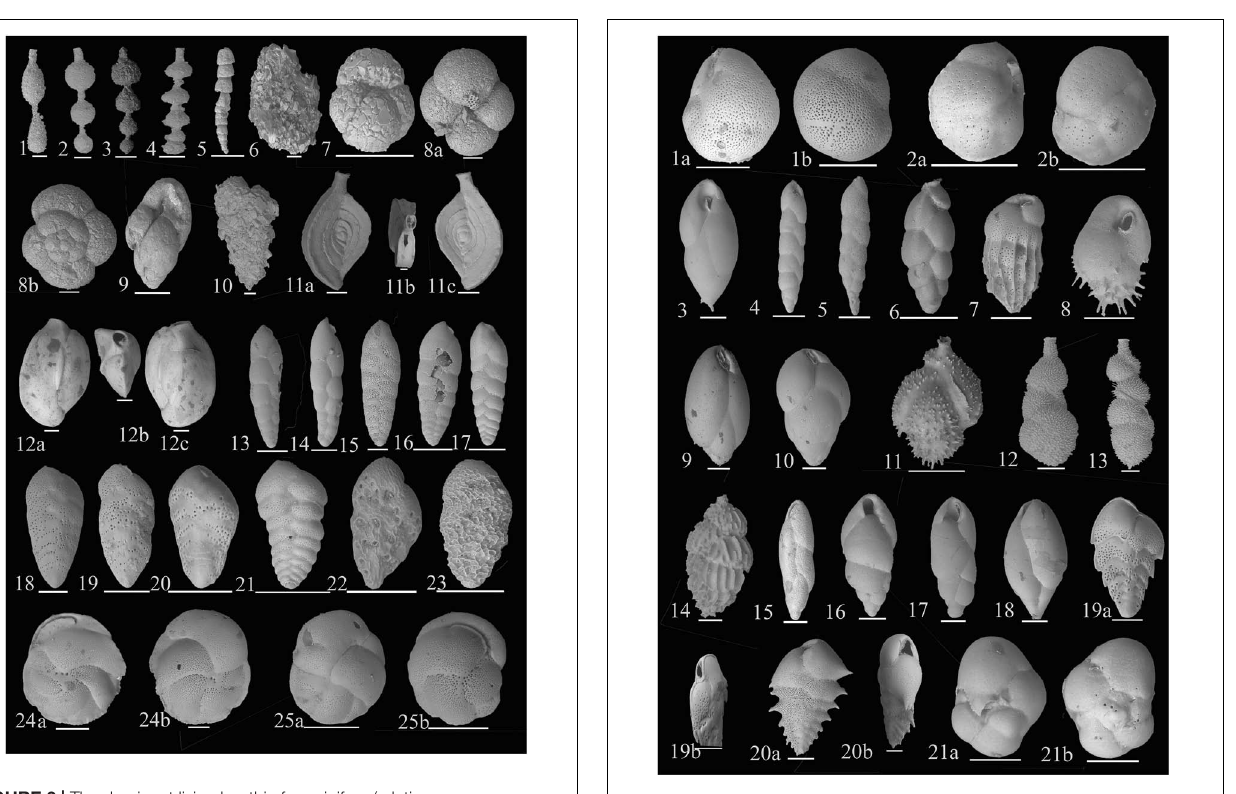
FIGURE 4 | (1) Globocassidulina oblonga (Reuss, 1850); (a) Ventral view (b) Dorsal view; (2, 3) Islandiella cushmani (Stewart and Stewart, 1930); (a,b) Side views (c) Apertural view; (3) Eubuliminella cassandrae (Revets, 1993); (4, 5) Eubuliminella exilis (Brady, 1884); (6) Hopkinsinella glabra (Millett, 1903); (7) Bulimina cf. delreyensis (Cushman and Galliher, 1934); (8) Bulimina marginata (d’Orbigny, 1826); (9) Globobulimina globosa (Leroy, 1944) (10); Protoglobobulimina pupoides (d’Orbigny 1846); (11) Uvigerina globulosa (Egger, 1895); (12, 13) Neouvigerina ampullacea (Brady, 1884); (14) Uvigerina peregrina (Cushman, 1923); (15) Fursenkoina pauciloculata (Brady, 1884); (16) Fursenkoina spinosa (Heron-Allen and Earland, 1932); (17) Fursenkoina schreibersiana (Czjzek, 1848); (18) Rutherfordoides rotundiformis (McCulloch, 1977); (19) Suggrunda alata (Seguenza 1862); (a) Side view (b) Lateral view showing aperture; (20) Suggrunda semiclara (McCulloch 1977); (a) Side view (b) Lateral view showing aperture; (21) Baggina irregularis (McCulloch, 1977); (a) Ventral view (b) Dorsal view. Scale bar is 100 µ